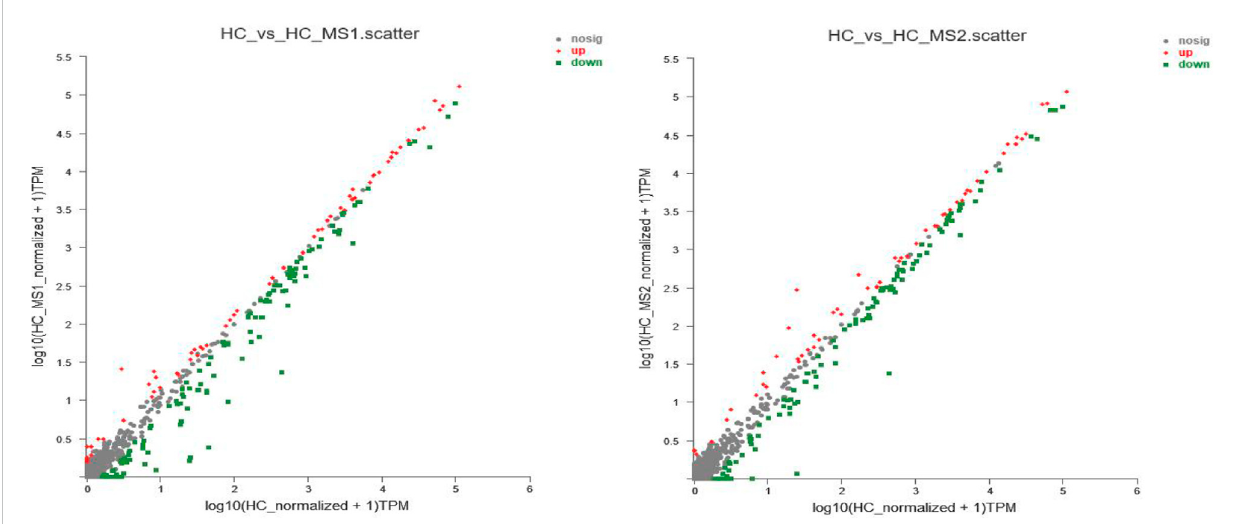
FIGURE 3 ScatterplotofmiRNAexpressionlevelsofthethreelibraries.Theabscissarepresentslog 10 (miRNAexpressionlevelofthestandardizedNFDgroup+ 1), the ordinate represents log 10 (miRNA expression level of standardized the HFD group + 1), and each point represents one miRNA. Red represents signi fi cant upward revision, and green represents signi fi cant downward revision (n =